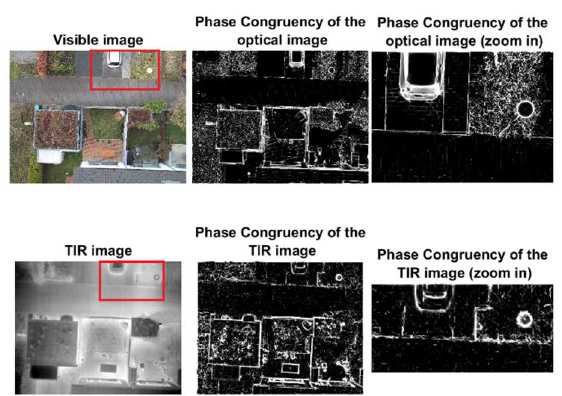
Figure 7. Phase Congruency of TIR and visible images with optimized